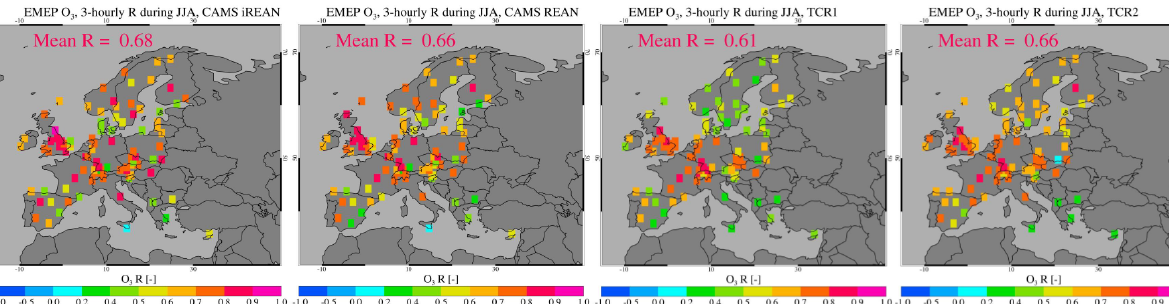
Figure 12. As Fig. 11 but for